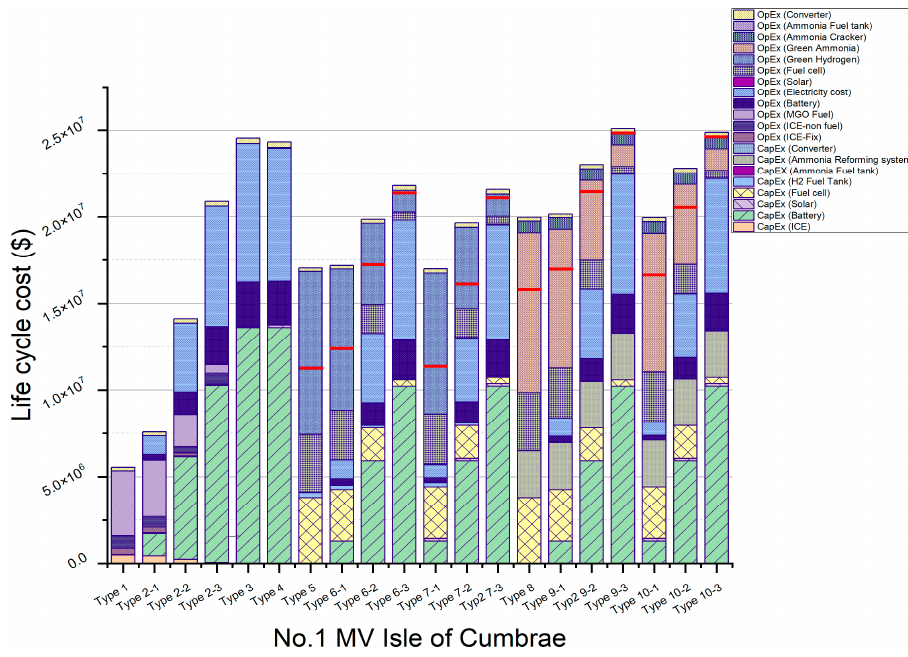
Figure 4. Result of LCCA for No. 1 case ship with the proposed types.